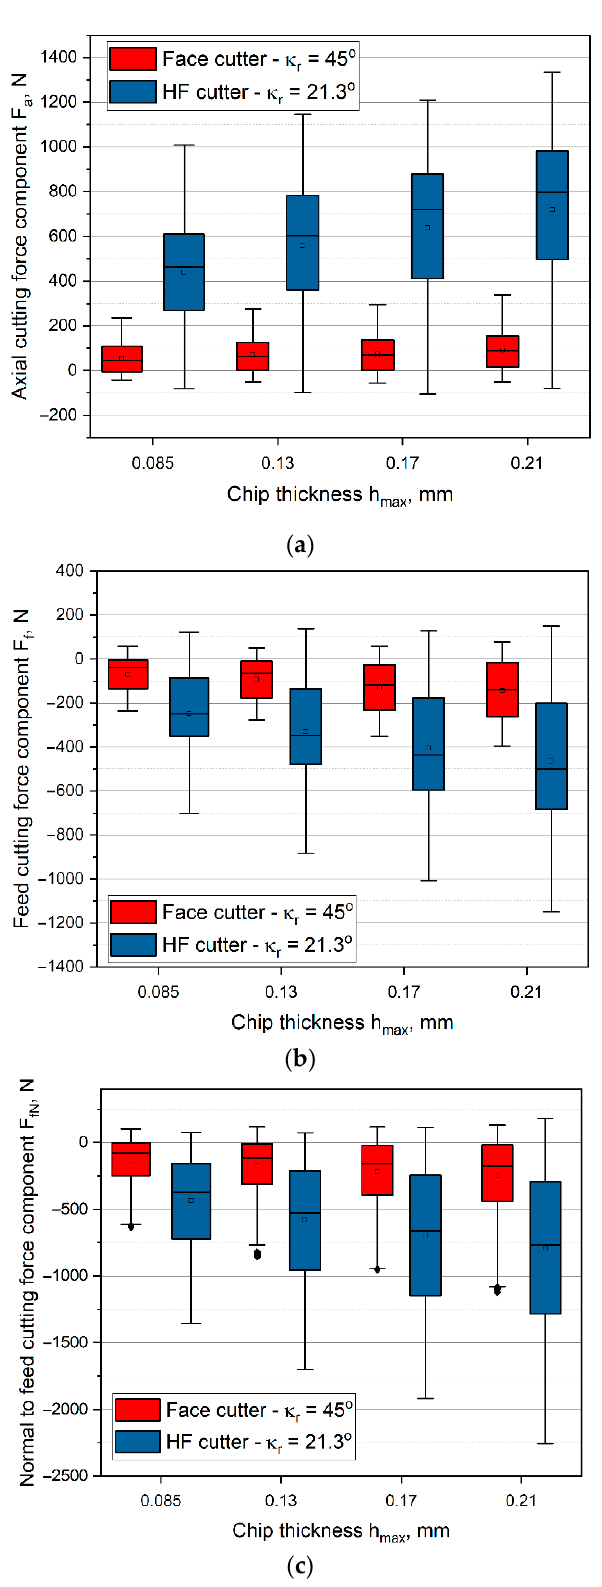
Figure 6. Cutting force components as a function of chip thickness h max in down milling with v c = 150 m/min, f z = 0.14–0.35 mm/tooth for face mill, and f z = 0.28–0.68 mm/tooth for HF mill: ( a ) F a , ( b ) F f , ( c ) F fN .